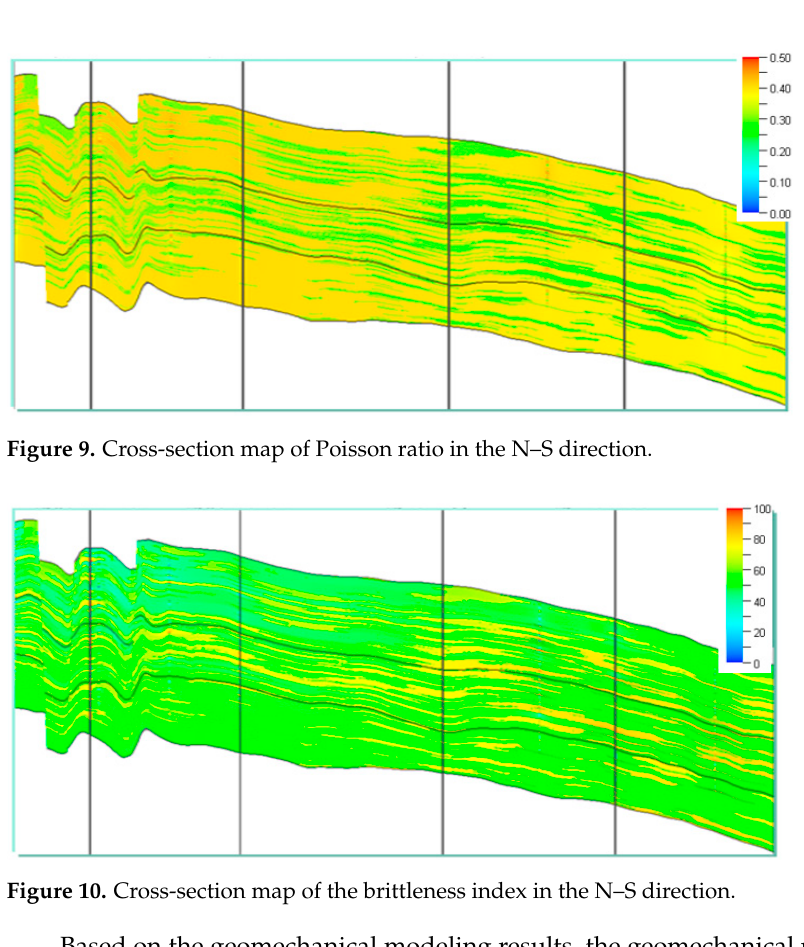
Figure 8. Cross-section map of Young’s modulus in the N–S direction.